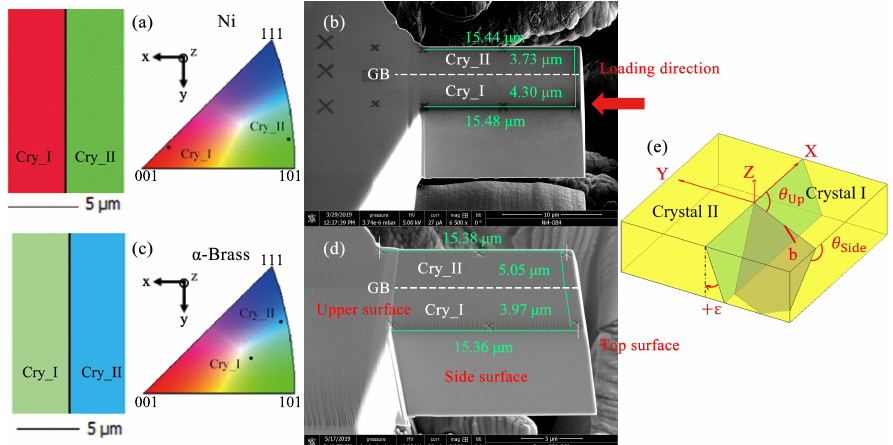
Figure 1. The crystallographic orientations of both crystals, Cry_I and Cry_II, are given in the standard IPF in the direction of the y -axis which is parallel to GB and is also the loading direction of the compression test for ( a ) Ni micro-pillar and ( c ) α -Brass micro-pillar. SEM micrograph of a micro-pillar containing GB cut by FIB for ( b ) Ni sample and ( d ) α -Brass sample; ( e ) schematic figure of slip line analyses: The sample coordinates are set as y perpendicular to GB line on the upper surface pointing towards crystal II, z perpendicular to the upper surface and x = y × z parallel to the GB line. The angle between the slip line and the GB line in a positive x -direction on the upper surface is noted as θ Up . The angle between the slip line and the upper edge of sample in a positive x -direction on the side surface is noted as θ Side . The inclination angle of GB is noted as ε